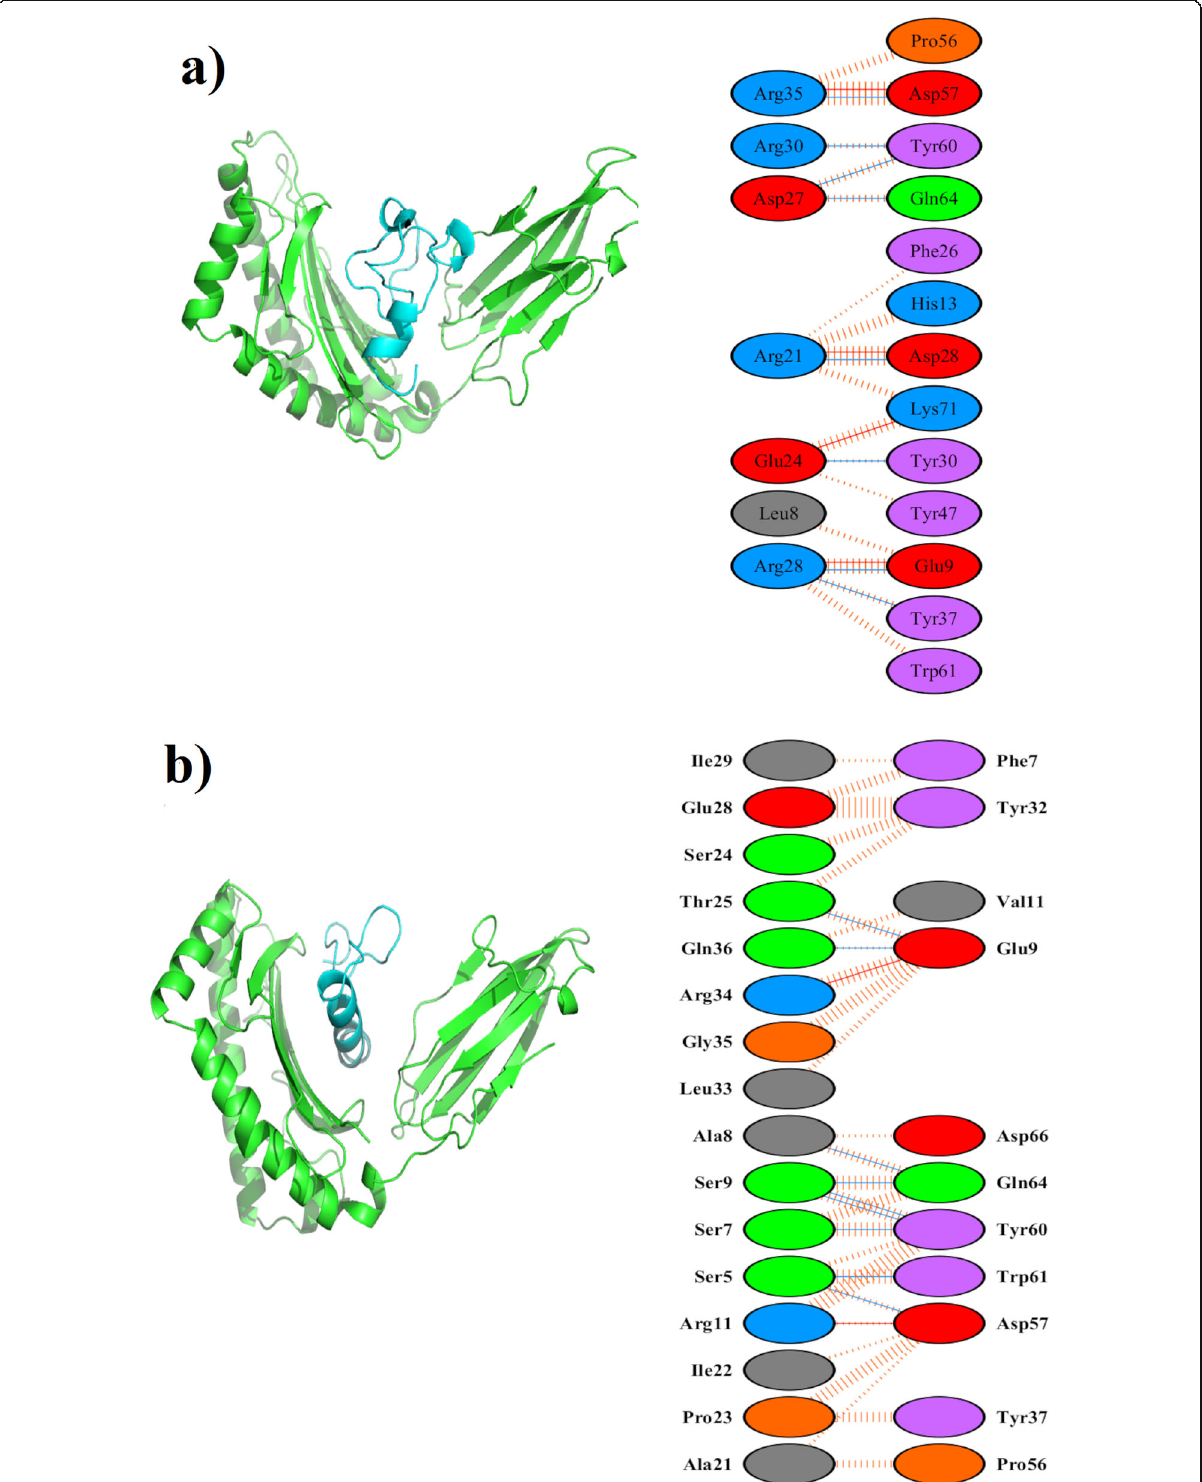
Fig. 2 Molecular docking studies. a Docked complex of IDE of Rv0295c-HLA-DRB1*04:01. Green denotes HLA-DRB1*04:01 and Cyan denotes IDE of Rv0295c. Interactions of IDE of Rv0295c-HLA-DRB1*04:01 are shown. b Docked complex of Rv1006-HLA-DRB1*04:01. Green denotes HLA- DRB1*04:01 and Cyan denotes IDE of Rv1006. Interactions of IDE of Rv1006-HLA-DRB1*04:01. Interactions of IDE of Rv1006-HLA-DRB1*04:01 are